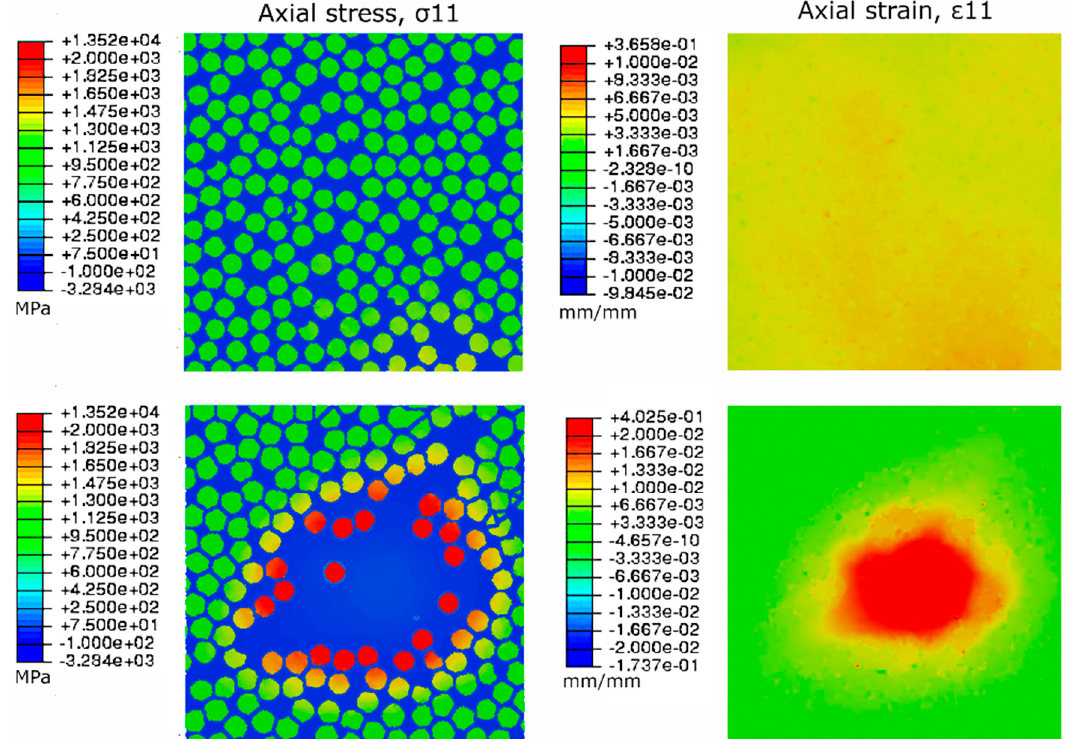
Figure 9. Comparison of reference microstructure ( top ) and resin-rich defect ( bottom ) in tension-dominated loading. Table 5. Comparison of strengths in defective and pristine samples.